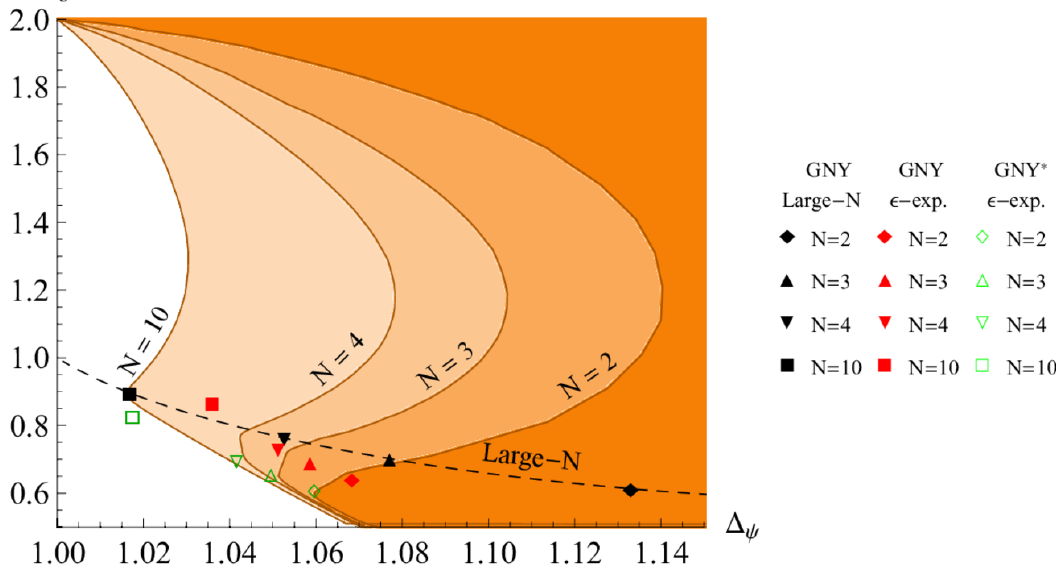
Figure 2 . Bound on the scaling dimension of the lowest-lying parity-odd O ( N ) singlet, (cid:1) (cid:27) , for a unitary CFT containing fermions with scaling dimension (cid:1) , when imposing a gap above this operator up to (cid:1) (cid:27) 0 > 3. Once again, we focus on the cases N = 2 ; 3 ; 4 ; and 10. We notice